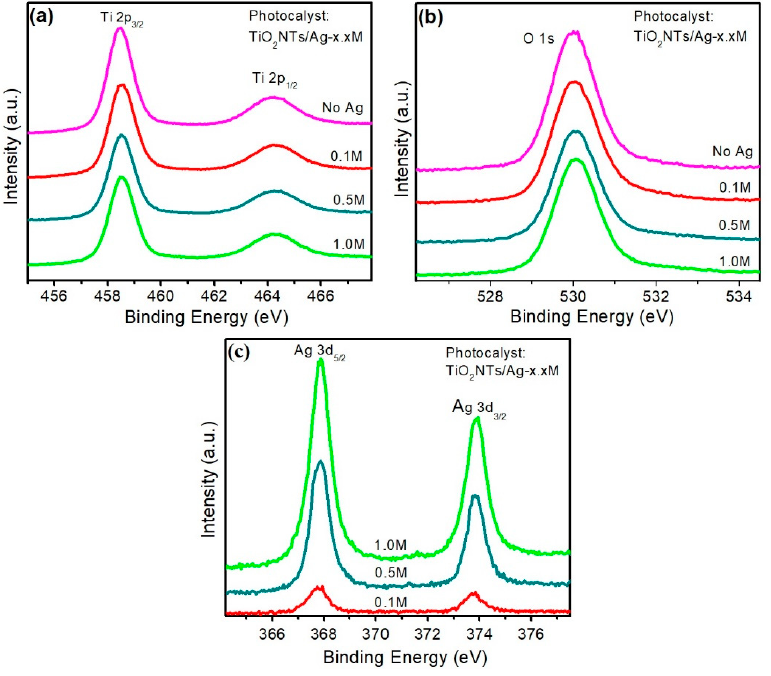
Figure 4. Fine-scan XPS spectra of ( a ) Ti 2p ( b ) O 1s and ( c ) Ag 3d.